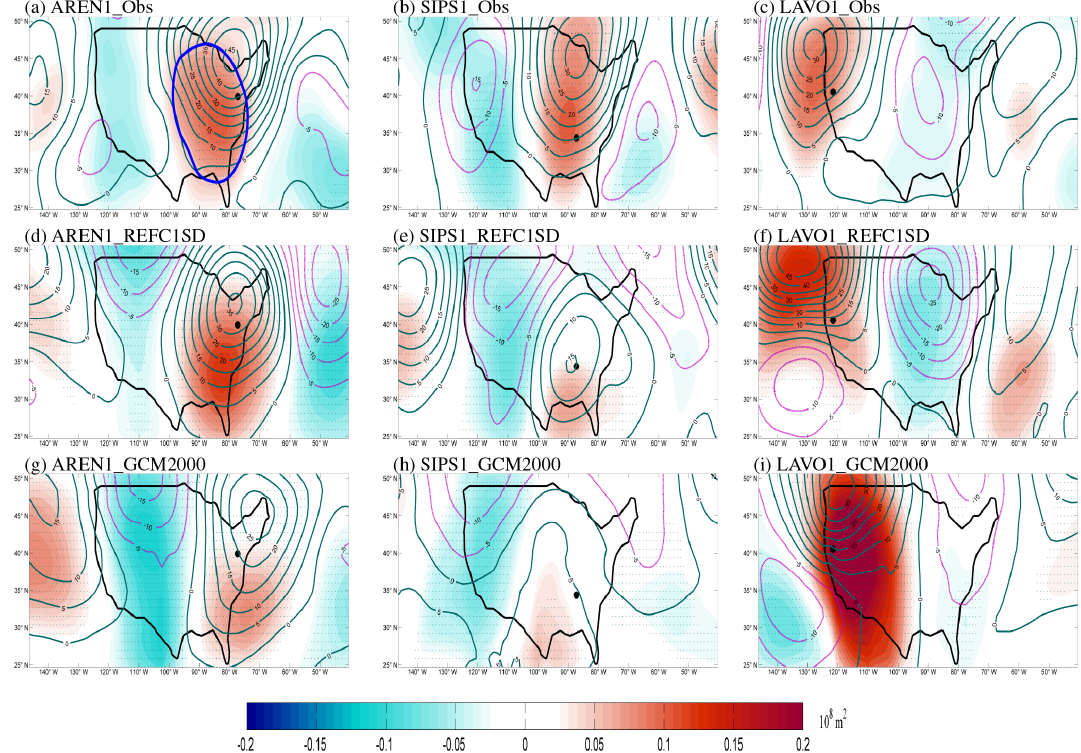
Figure 5. Composite 500hPa geopotential height anomaly (contours; positive values are represented by green lines and negative values by magenta lines) and (shaded) corresponding AWA for PM 2 . 5 larger than the 90th quantile at sites (denoted by the black dots) (a, d, g) AREN1, (b, e, h) SIPS1 and (c, f, i) LAVO1. The top row shows results using IMPROVE PM 2 . 5 and reanalysis AWA, the middle row uses the reanalysis-driven simulated PM 2 . 5 (REFC1SD) and reanalysis AWA, and the bottom row uses current-climate-simulated PM 2 . 5 and AWA (GCM2000). Stippling indicates the regions that are statistically significant at the 5% confidence level. Unit: meters for 500hPa geopotential height and 10 8 m 2 for AWA. The blue outlined area in (a) is the impact region, which is defined as the region of the maximum regression coefficient minus